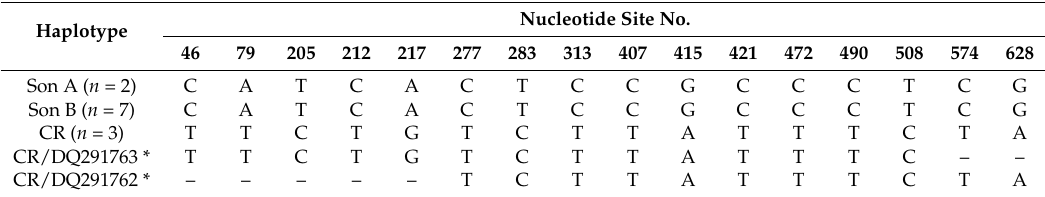
Table 3. Diagnostic nucleotide differences in COI barcodes between Sonora (Son; haplotypes A and B; shaded) and Costa Rica (CR) specimens of Achalarus toxeus .